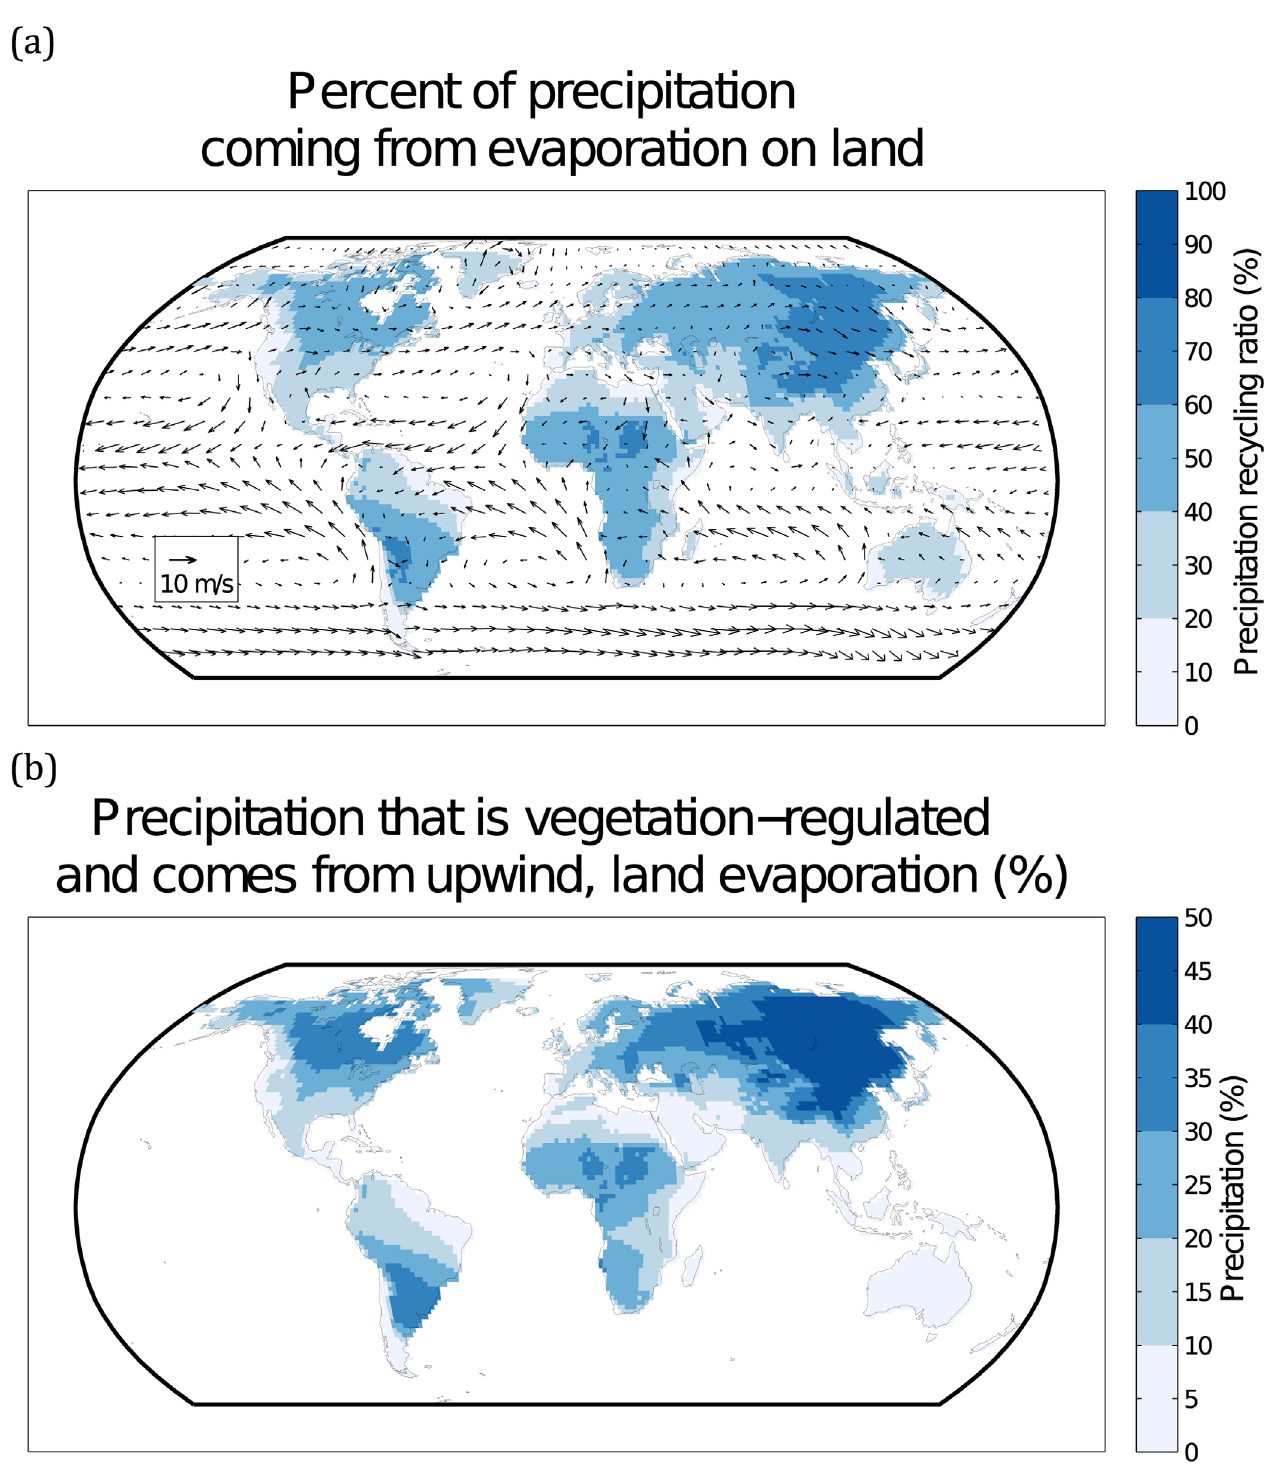
Fig 2. Global Sinks of Vegetation-regulated Moisture Recycling, showing the amount of precipitation on land that originates as upwind evaporation from land (a); and, the amount of precipitation that comes from upwind vegetation-regulated evaporation (b). The arrows in panel (a) depict annual average wind directions in the lower level of the atmosphere. Note that the maximum of (b) is